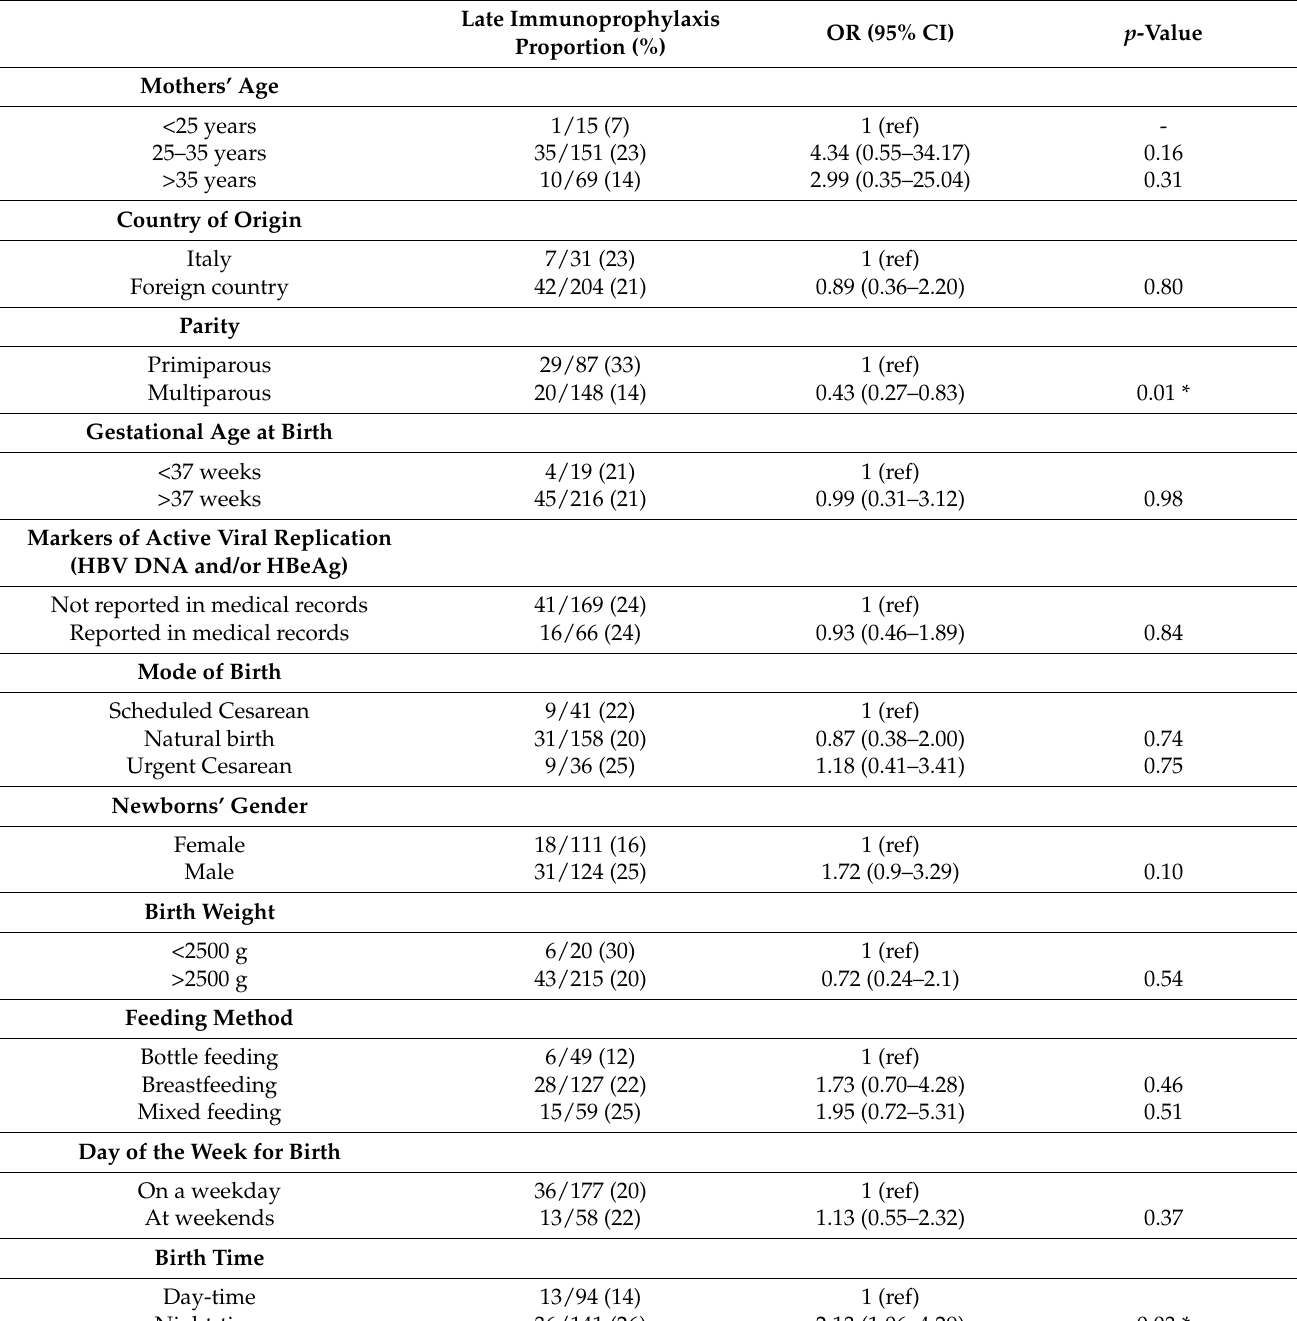
Table 2. Risk factors for late immunoprophylaxis at birth (>12 h from birth) in babies born to HBsAg positive mothers. Abbreviations: OR = Odds Ratio; CI = Confidence Intervals; g = grams. * significant risk factors ( p -value ≤